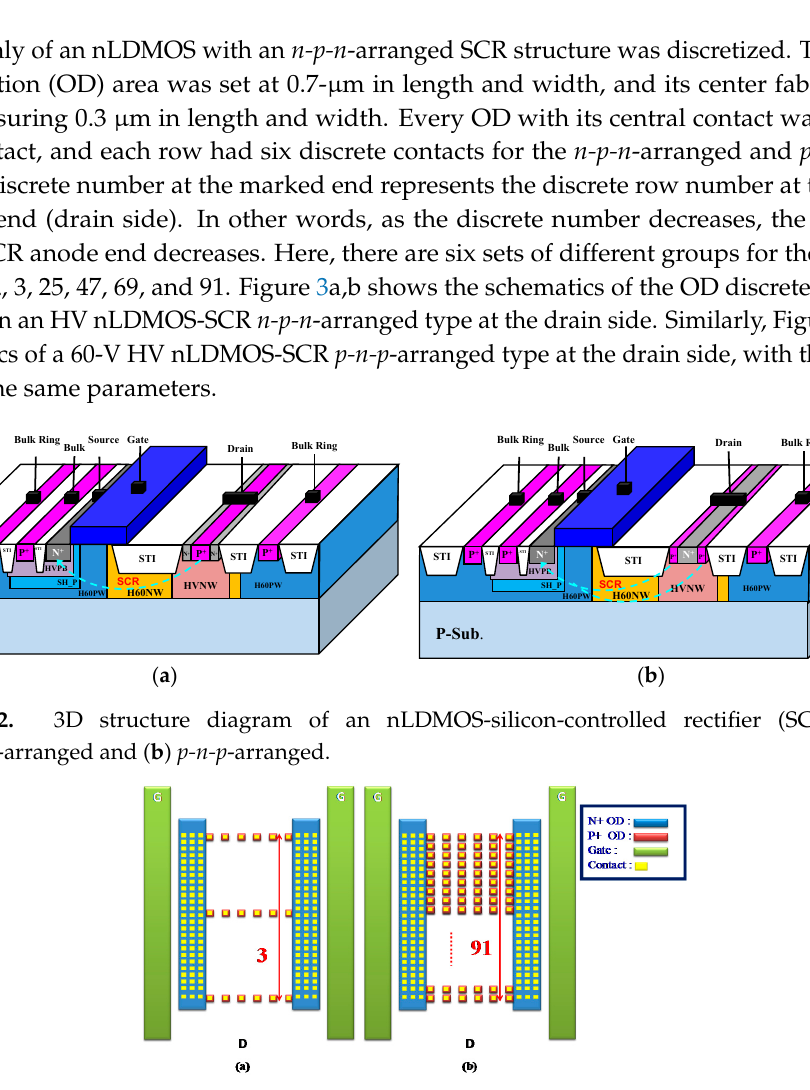
Figure 3. Schematic diagram of an nLDMOS-SCR ( n-p-n -arranged and discrete-anode type): ( a ) DIS_3 and ( b ) DIS_91.